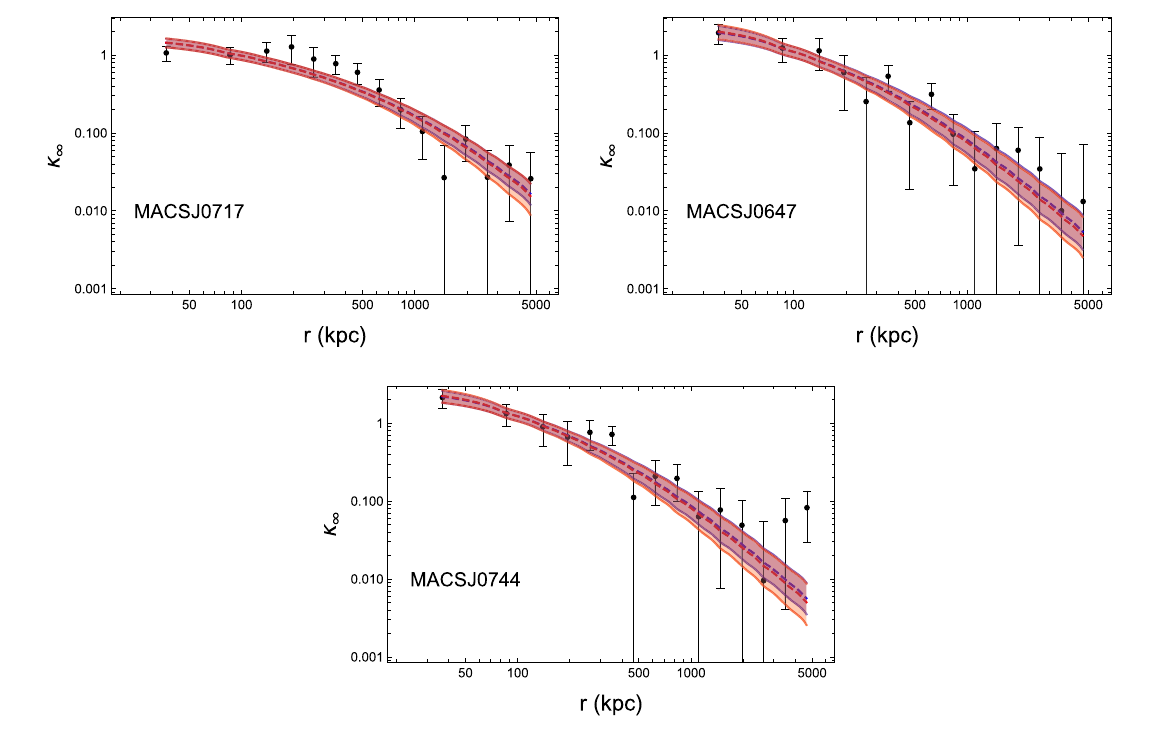
Fig. 10 Profiles: blue—GR; red—nonlocal